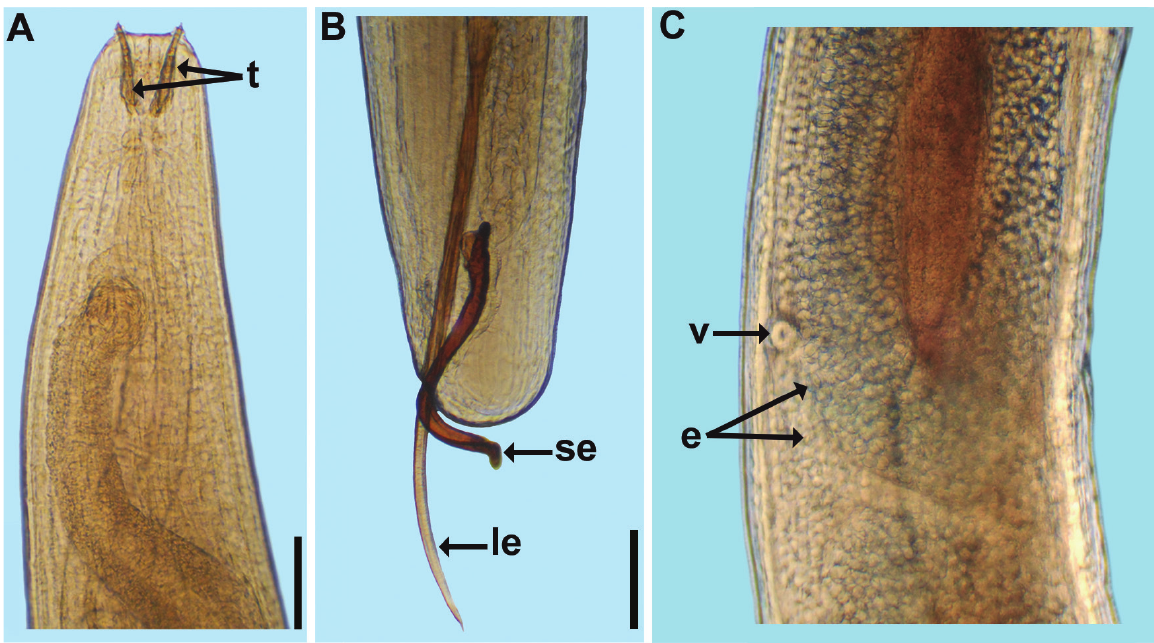
Figure 1. Photomicrographs of Diplotriaena delirae Pinto & Noronha, 1970. A. Lateral view of the anterior extremity showing the tridents (t). Scale bar = 580µm. B. Posterior extremity of a male, showing the large (le) and small (se) spicules. Scale bar = 230µm. C. Vulvar region of the female showing the vulva (v) and eggs (e). Scale bar = 200